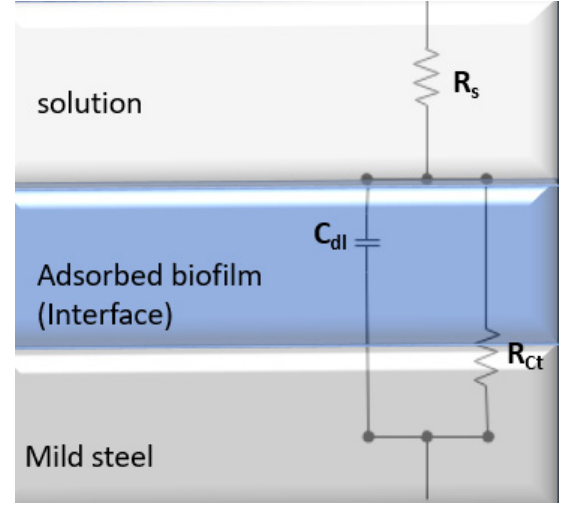
Figure 8. Suggested equivalent circuit.